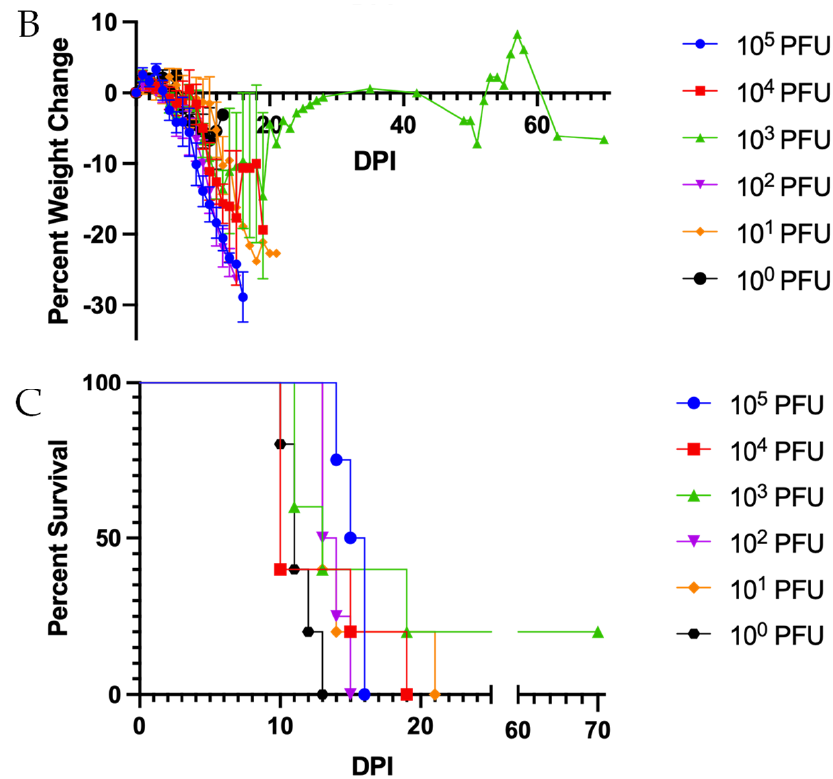
Figure 1. ML29 causes a lethal infection in STAT1-/- mice with an LD50 of <1 PFU. STAT1-/- mice were inoculated with 10 0 to 10 5 PFU of ML29. ( A ) Changes in body temperature post-infection. ( B ) Changes in body weight post-infection. ( C ) Percent survival: 10 4 , 10 3 , 10 1 , and 10 0 PFU n = 5; 10 5 and 10 2 PFU n = 4. Data presented as average ± SEM for temperature and weight changes.